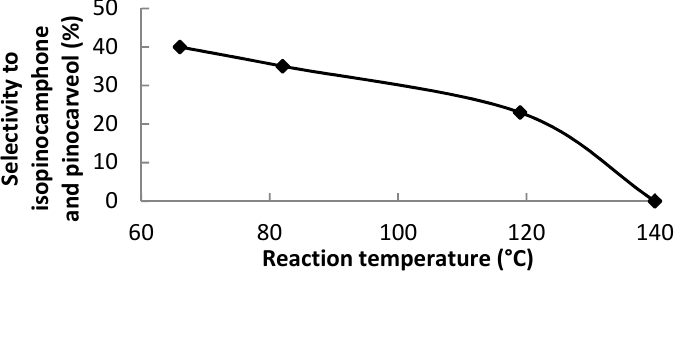
Figure 10. The sum of selectivities to isopinocamphone and pinocarveol as a function of the reaction